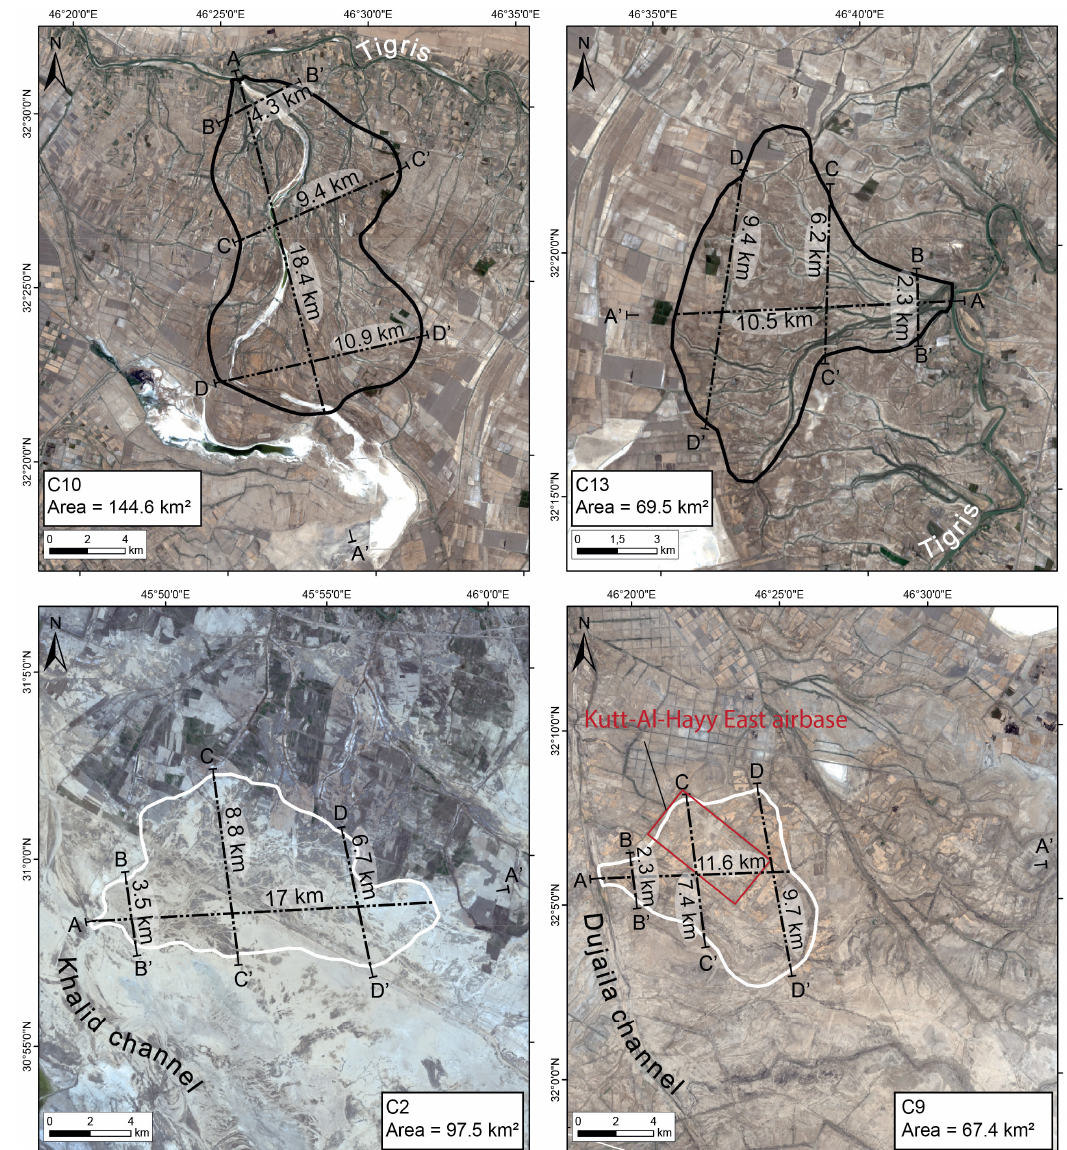
Figure 6. Example of active ( C10 , C13 ) and abandoned ( C2 , C9 ) crevasse splays recognized in the area. The traces of altimetric profiles shown in Figures 8 and 9 are reported: AA’: along-dip profiles, BB’: cross-direction profiles of the proximal sector, CC’: cross-direction profiles of the middle sector, DD’: cross-direction profiles of the distal sector.